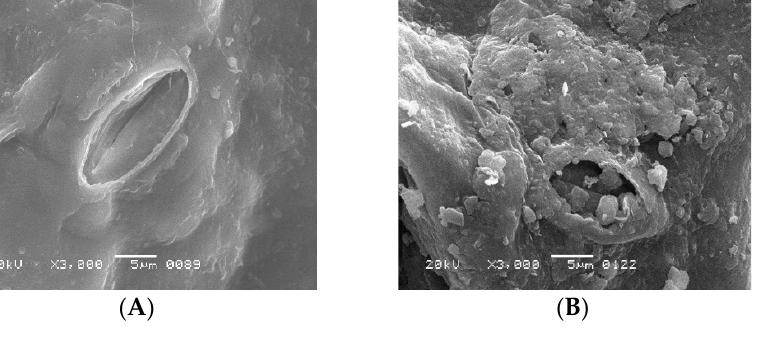
Figure 1. ( A ) regular shape of stomatal opening of S. oleracea Plant “a”, ( B ) distorted and closed shape of stomatal opening of S. oleracea Plant “b”, and ( C ) distorted and closed shape of stomatal opening of S. oleracea Plant “c”.